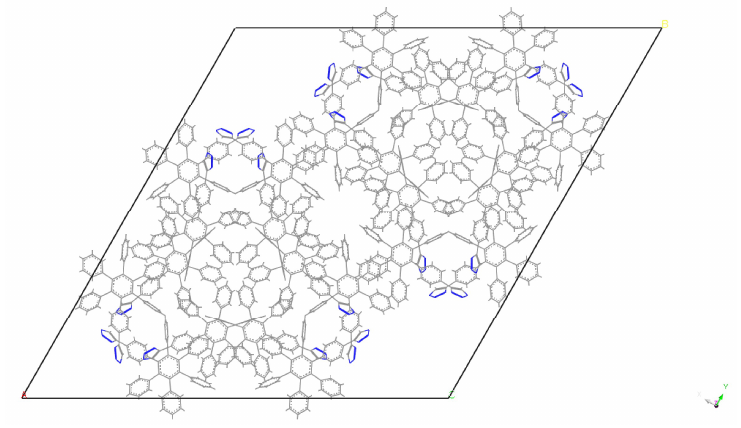
Figure 6. Molecular packing of aromatic fragments to the crystal cell. Only the HPB fragments are shown in the presented packing solutions.